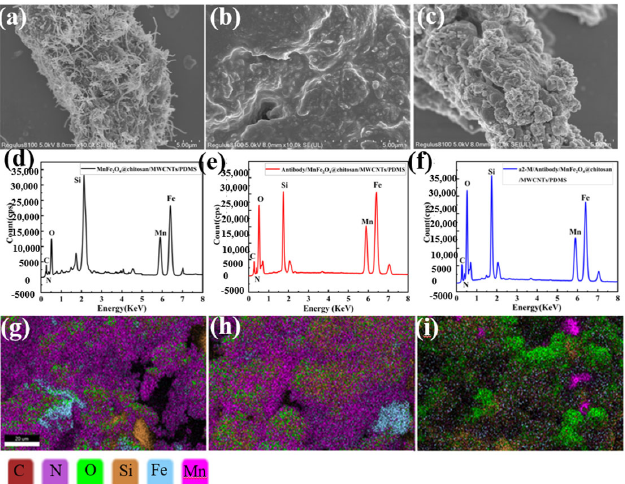
Figure 7. SEM ( a ) and EDS analysis ( d ) and EDS images ( g ) of the MnFe 2 O 4 @chitosan/MWCNTs/PDMS biosensor surface; SEM ( b ) and EDS analysis ( e ) and EDS images ( h) of the